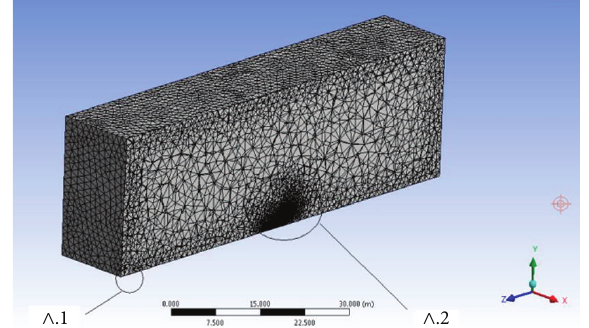
Figure 5: The computational grid is comprised of 1037091 grid nodes. Nodes are densely located close to solar panels.